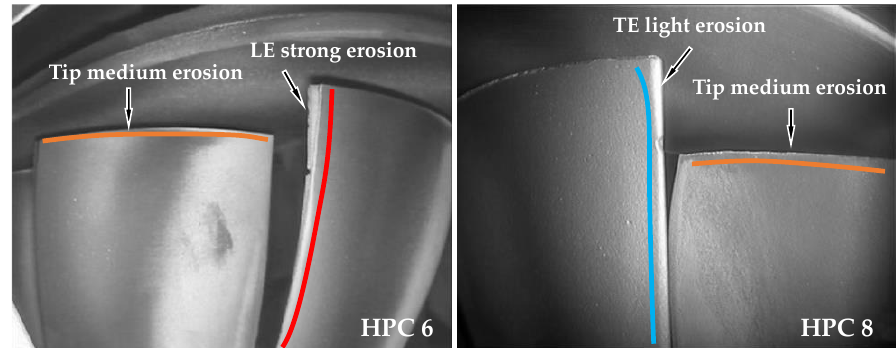
Figure 8. Erosion blades of the 6th and 8th high-pressure compressors.